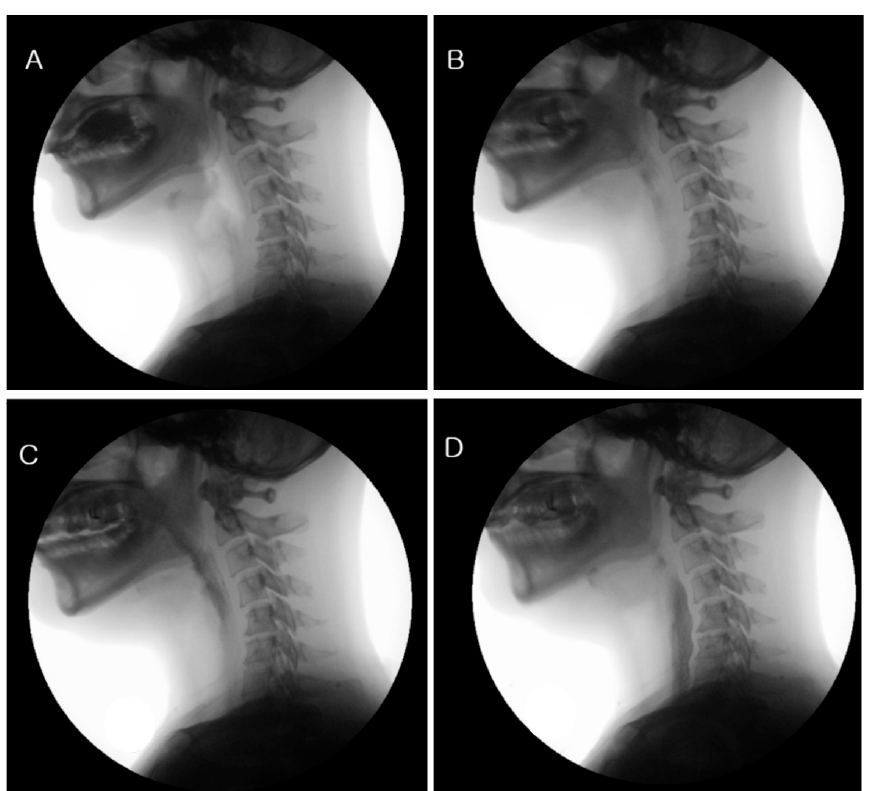
Figure 3. Pharyngeal transit time on VFSS. ( A ) An Oral phase. ( B , C ) Pharyngeal transit time is defined as the time it takes for the bolus to pass from the faucial arches over the base of the tongue and through the pyriform sinus in the esophagus. ( D ) Esophageal phase.